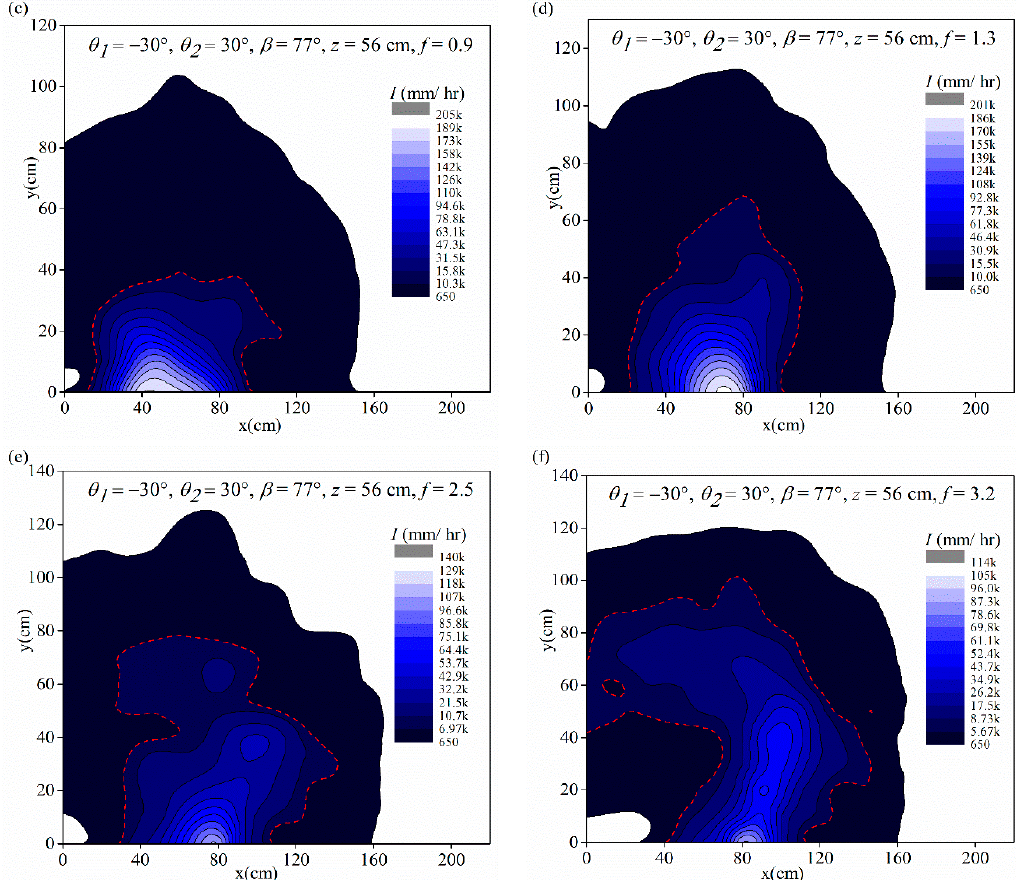
Figure 4. Rainfall intensity distribution at different flow ratios on the x - o - y measuring platform. ( a ) θ 1 = − 30 ◦ , θ 2 = 30 ◦ , β = 77 ◦ , z = 56 cm, and f = 0.3; ( b ) θ 1 = − 30 ◦ , θ 2 = 30 ◦ , β = 77 ◦ , z = 56 cm, and f = 0.6; ( c ) θ 1 = − 30 ◦ , θ 2 = 30 ◦ , β = 77 ◦ , z = 56 cm, and f = 0.9; ( d ) θ 1 = − 30 ◦ , θ 2 = 30 ◦ , β = 77 ◦ , z = 56 cm, and f = 1.3; ( e ) θ 1 = − 30 ◦ , θ 2 = 30 ◦ , β = 77 ◦ , z = 56 cm, and f = 2.5; ( f ) θ 1 = − 30 ◦ , θ 2 = 30 ◦ , β = 77 ◦ , z = 56 cm, and f = 3.2.